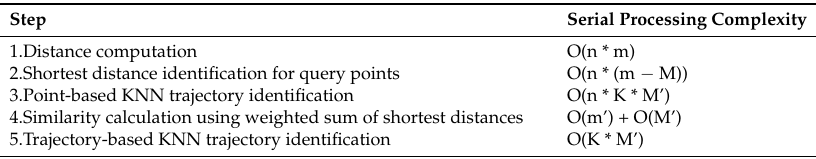
Table 1. The complexity analysis of the major steps of K-BCT